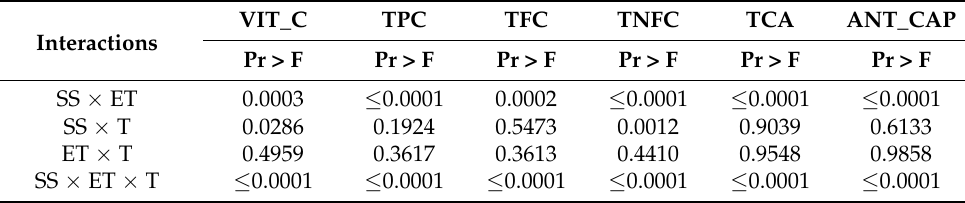
Table 4. Significance analysis of interactions of experiment factors for specialized